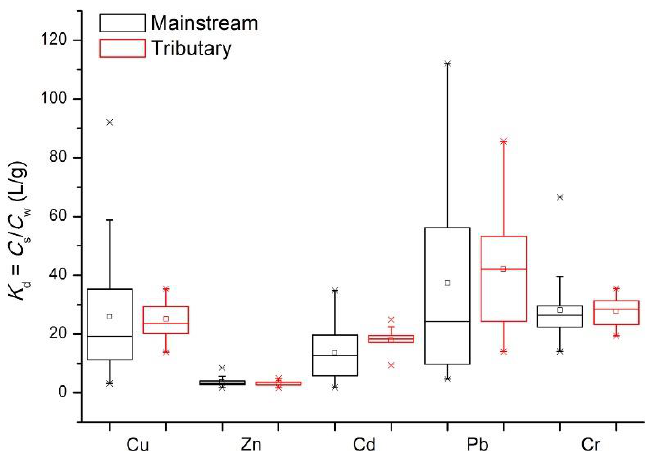
Figure 9. Statistical analysis of the heavy metal partition between the surface sediment and bottom water samples, with the sites from the mainstream and tributaries separately presented. Table 3. Correlation analysis between the K d values and environmental variables.